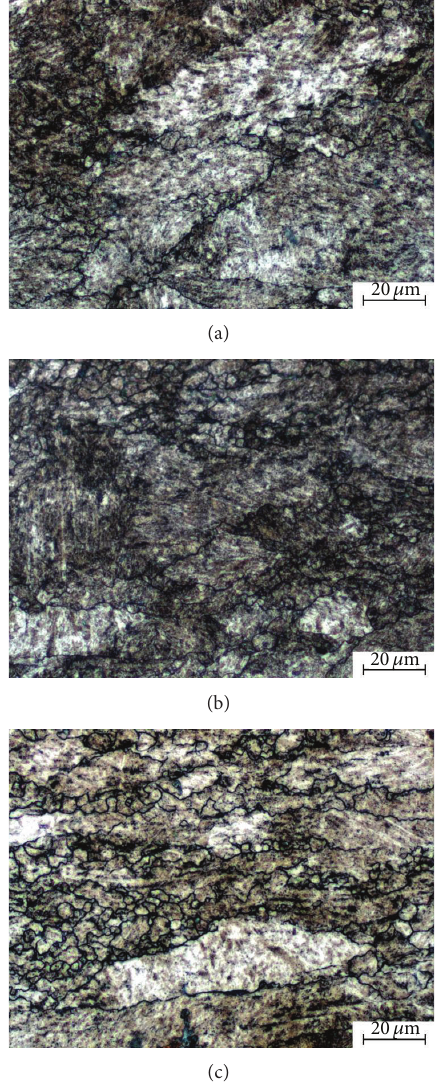
Figure 14: Micrographs of specimens deformed at 950 ∘ C at the strain rate of 0.1s −1 with the strain of (a) 0.4, (b) 0.6, and (c)